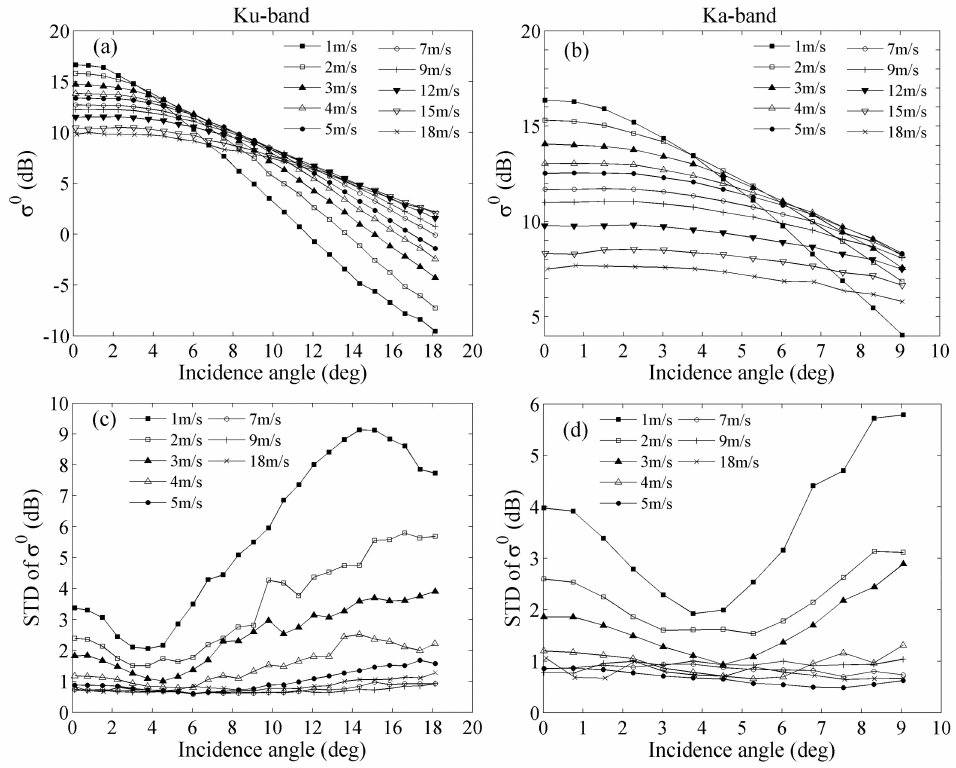
Figure 5. Mean values and standard deviations of binned KuPR ( a,c ) and KaPR ( b,d ) σ 0 as functions of incidence angle for different wind speeds.